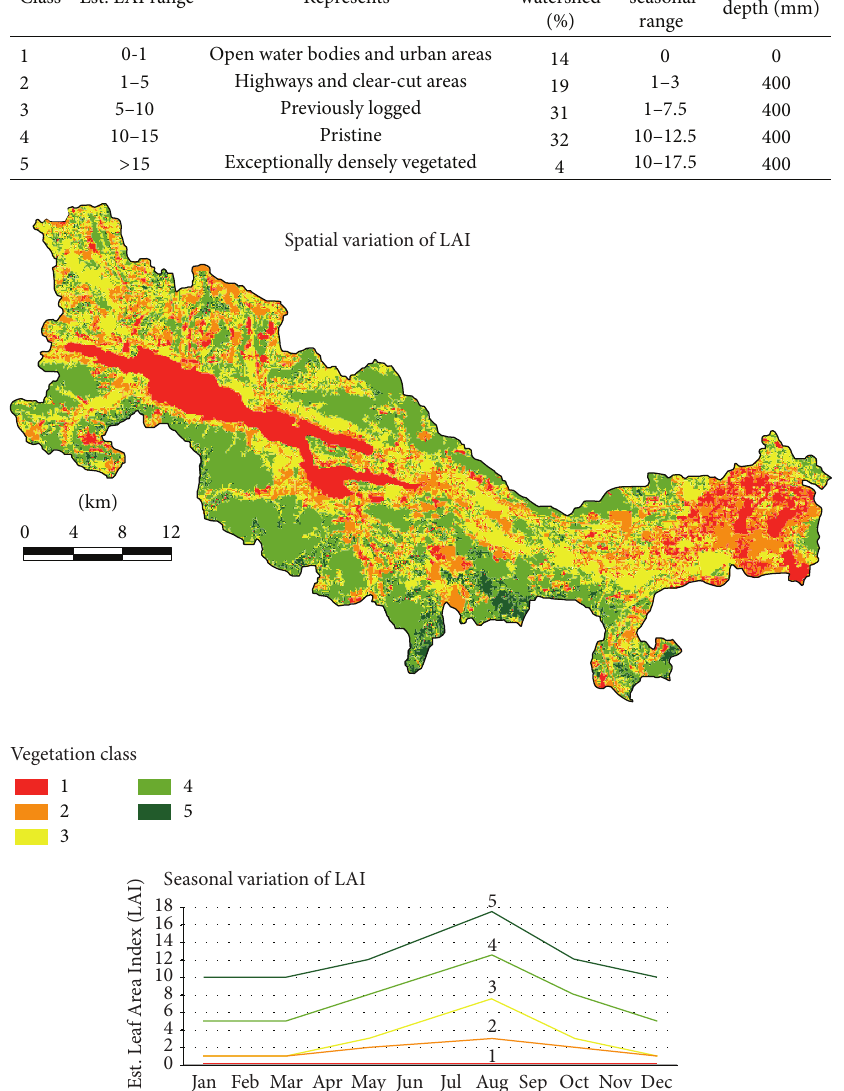
Figure 5: Spatial and seasonal variations of leaf area index (LAI) within the Cowichan